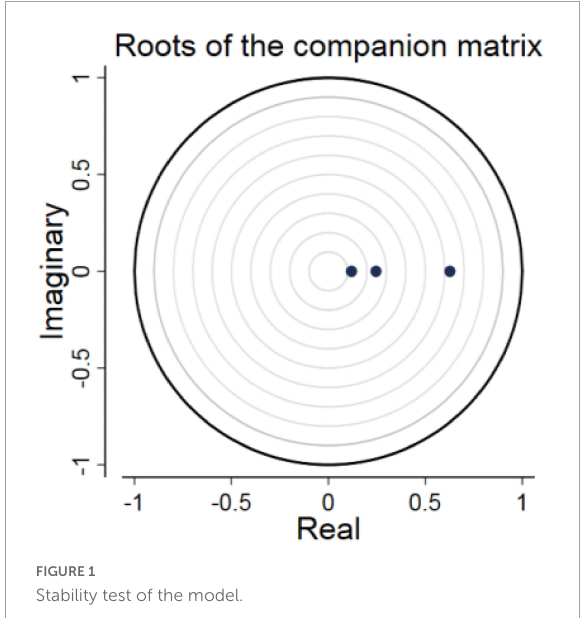
FIGURE1 Stability test of the